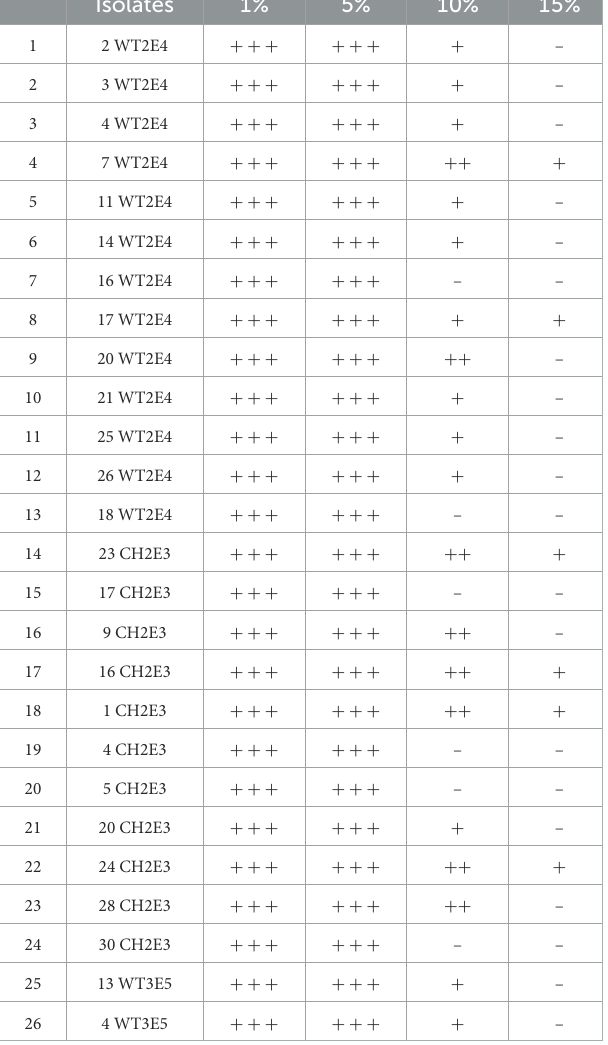
TABLE 3 Results of the halotolerance test corresponding to the selected isolates at four salinity levels (1%, 5%, 10%, and 15% NaCl).